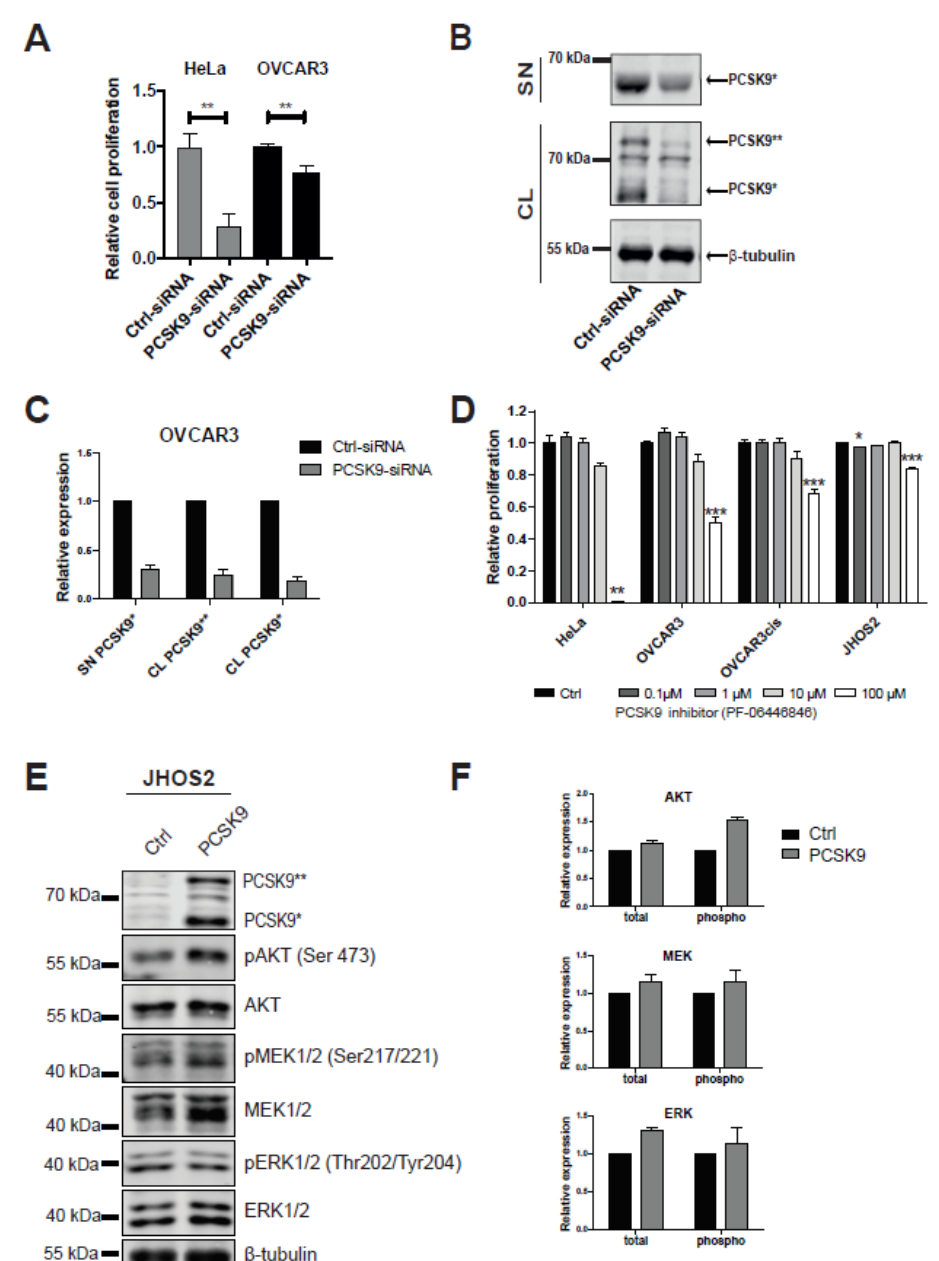
Figure 2. Targeting PCSK9 expression impairs OC cell viability. ( A ) Relative cell proliferation of OVCAR3 and HeLa cells treated with control or PCSK9-siRNA for 48 h. Statistical significance was tested using a two-tailed t -test (* indicates p -value < 0.05 and *** indicates p -value <0.001). ( B ) Western blot analysis of PCSK9 isoform levels following 48 h siRNA treatment from OVCAR3 supernatant (SN) and cell lysate (CL). ( C ) Quantification of PCSK9** and PCSK9* isoform levels from (B). An arbitrary value of 1 was given to PCSK9 isoform levels in control siRNA treated cells. Error bars indicate − /+ SEM of 3 independent experiments. ( D ) Relative cell survival of HeLa, OVCAR3, OVCAR3cis (PCSK9-positive) and JHOS2 cells (PCSK9-negative) treated with increasing amounts of PCSK9 inhibitor PF-06446846 for 48h. Statistical significance was calculated using two-tailed t -test (* indicates p -value < 0.05; ** indicates p -value < 0.01; *** indicates p -value < 0.001). ( E ) Western blot analysis of JHOS2 cell lysates non-transfected or transfected with PCSK9 for 48 h. ( F ) Quantification of phosphorylated and total AKT, ERK and MEK protein levels from ( E ). Arbitrary value of 1 was given to the indicated protein levels in control (non-transfected) sample. Error bars indicate -/+ SEM of 3 independent experiments. The uncropped Western Blot images can be found in Figure S2 and signal values are listed in Table